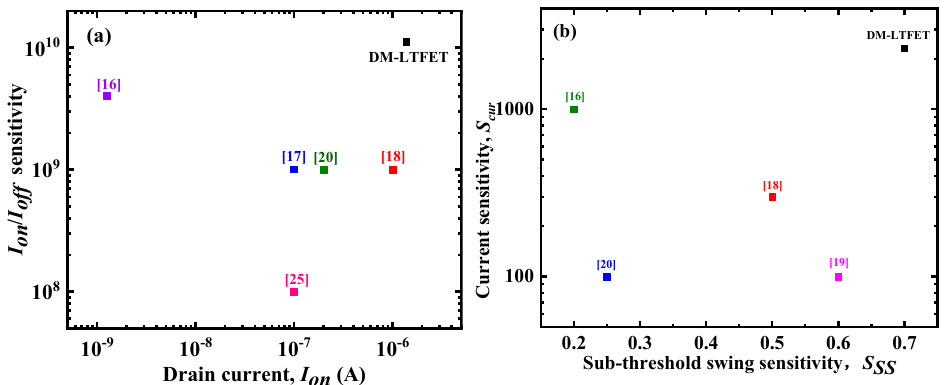
Figure 9. Comparison of the I on / I off sensitivity and current sensitivity of the DM-LTFET sensor with the other TFET based sensors in terms of ( a ) the on-state current and ( b ) the sub-threshold swing sensitivity.